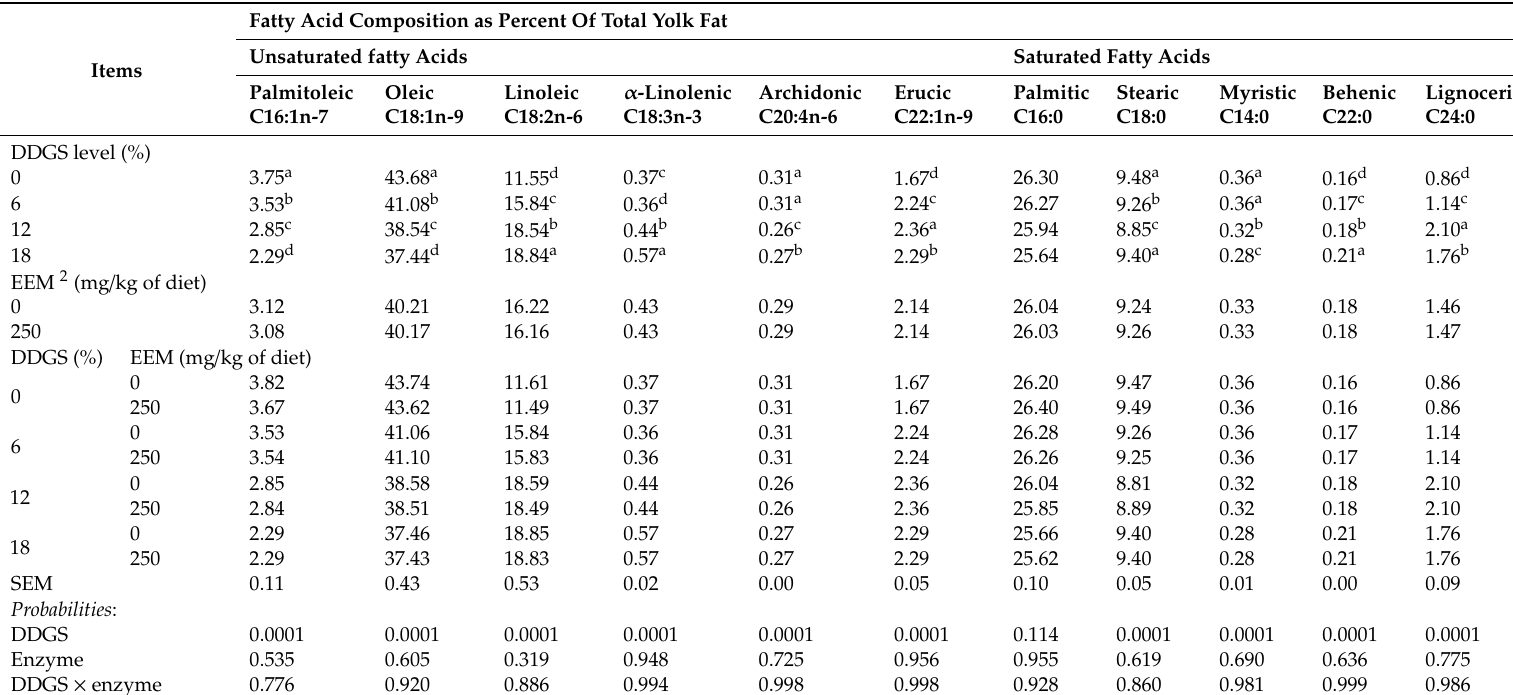
Table 6. Egg yolk fatty acids of laying hens organized by DDGS 1 inclusion levels and enzyme supplementation through 32–42 weeks of